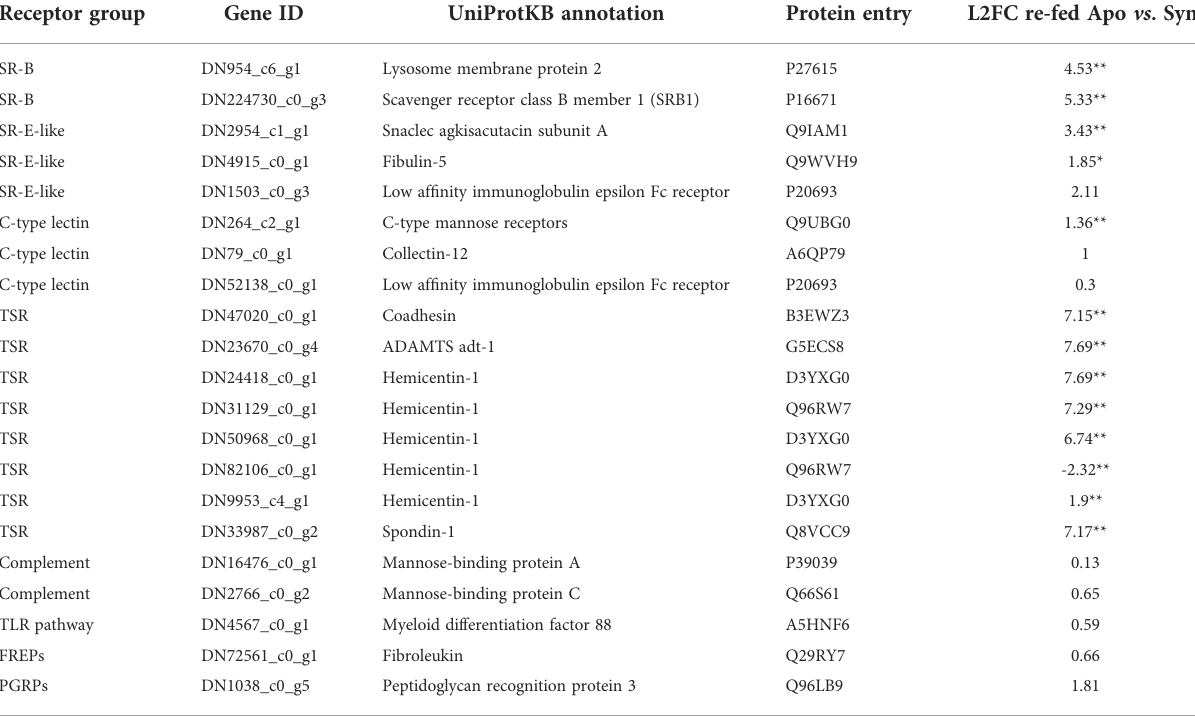
TABLE 1 Innate immune genes potentially involved in the photosymbiosis initiation in Berghia stephanieae. Receptor